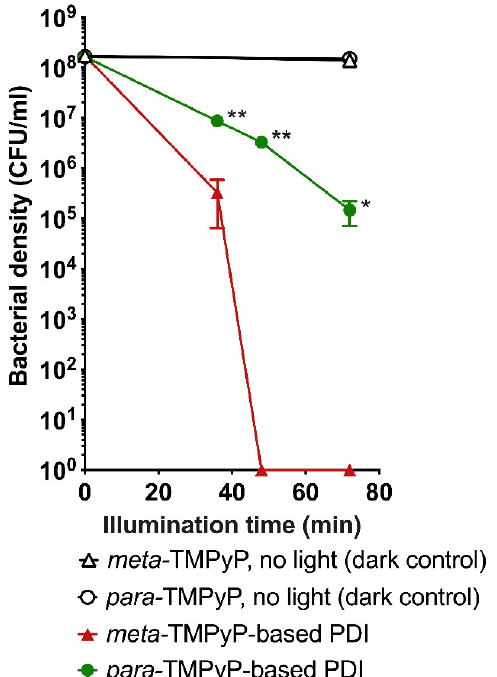
Figure 6. Dose-dependent effects of LED-based photodynamic inactivation based on meta -TMPyP in comparison to para -TMPyP . Increasing durations of light illumination (illumination dose) during the PDI experiment with meta -TMPyP or para -TMPyP (400 µ M) led to a reduction of bacterial density in multidrug-resistant Escherichia coli . The effects of meta -TMPyP -based PDI were significantly stronger after illumination times of 36, 48, and 72 min (* p < 0.05; ** p < 0.01; light dose 28–56 J/cm 2 ) compared to para -TMPyP . Dark controls without illumination showed no reduction of bacterial density. Data are represented as mean ±